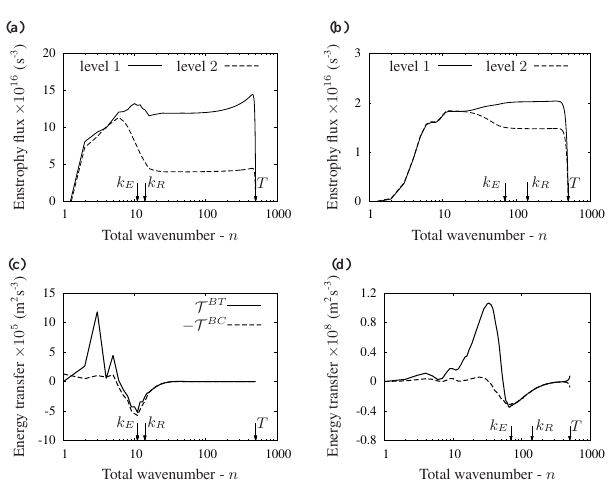
Figure 2. Spectral properties of the benchmark simulations. Poten- tial enstrophy flux spectra on the upper vertical level (level 1) and lower level (level 2) for the (a) atmosphere and (b) ocean. Energy transferred into the barotropic mode ( T BT ) and out of the baro- clinic mode ( − T BC ) for the (c) atmosphere, with legend also ap- plicable to panel (d) ; and (d) ocean. The energy-containing-scale wavenumber k E , Rossby wavenumber k R , and benchmark simula- tion truncation wavenumber T labelled on the n